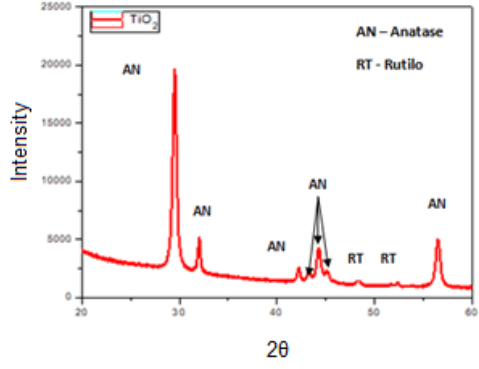
Figure 2 T itanium dioxide (TiO 2 ) diffractogram.